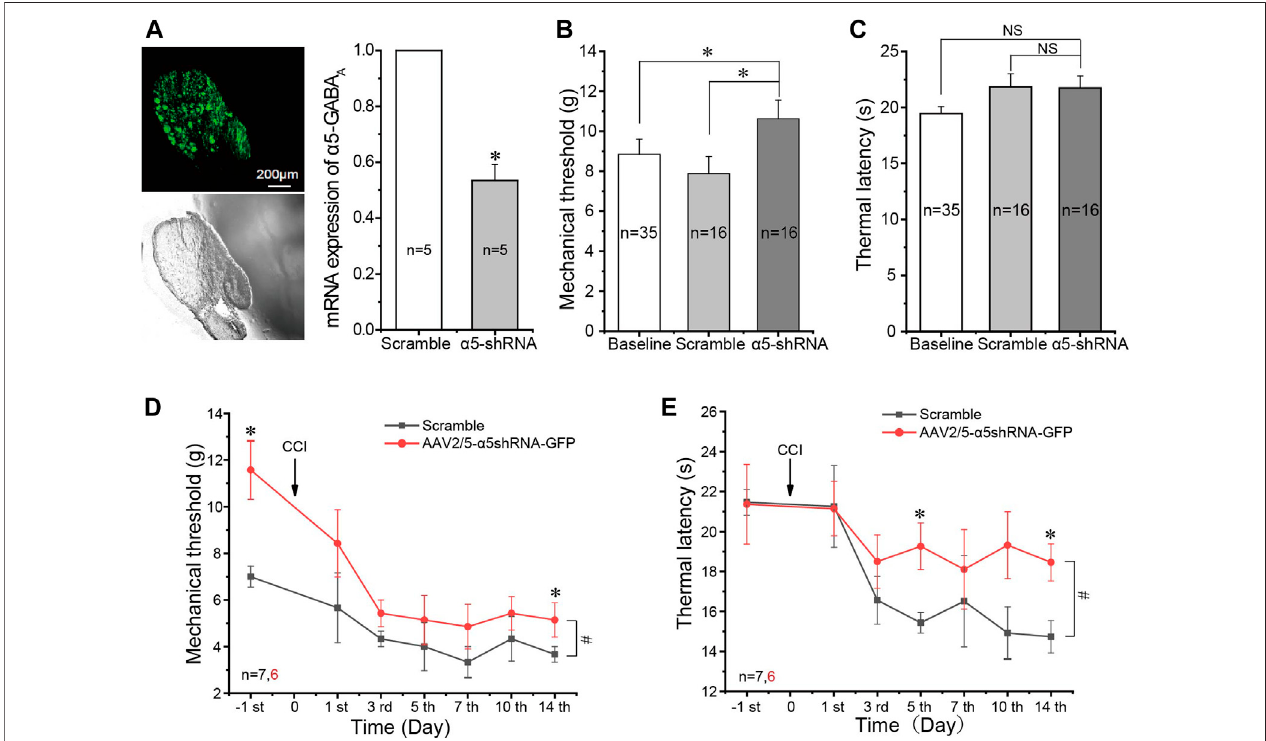
FIGURE 5 | In vivo silencing of the α 5 GABA A subunit alleviates neuropathic pain. ( A) Injection of AAV2/5- α 5 shRNA-GFP into the L5 DRG of rats in vivo produced strong fl uorescence in the DRG and signi fi cantly reduced mRNA expression of the α 5 subunit in the DRG ( n (cid:2) 5), * p < 0.05 (unpaired t test). (B) Injection of AAV2/5- α 5 shRNA-GFP into the L5 DRG of rats signi fi cantly increased the mechanical threshold as compared to the baseline threshold and injected scrambled RNA, * p < 0.05 (one-way ANOVAwith the LSD post hoc test). (C) Nosigni fi cantchange ofthermal latency. (D,E) Injection ofAAV2/5- α 5 shRNA-GFP into the L5 DRG signi fi cantly alleviated mechanical (D) and thermal (E) hyperalgesia produced by CCI. Repeated measures ANOVA with the Bonferroni correction was used for comparison of hyperalgesia measurements between the groups, # p < 0.05; one-way ANOVA was used for comparison within the corresponding time point: * p < 0.05. Number of experiments is indicated as n in each